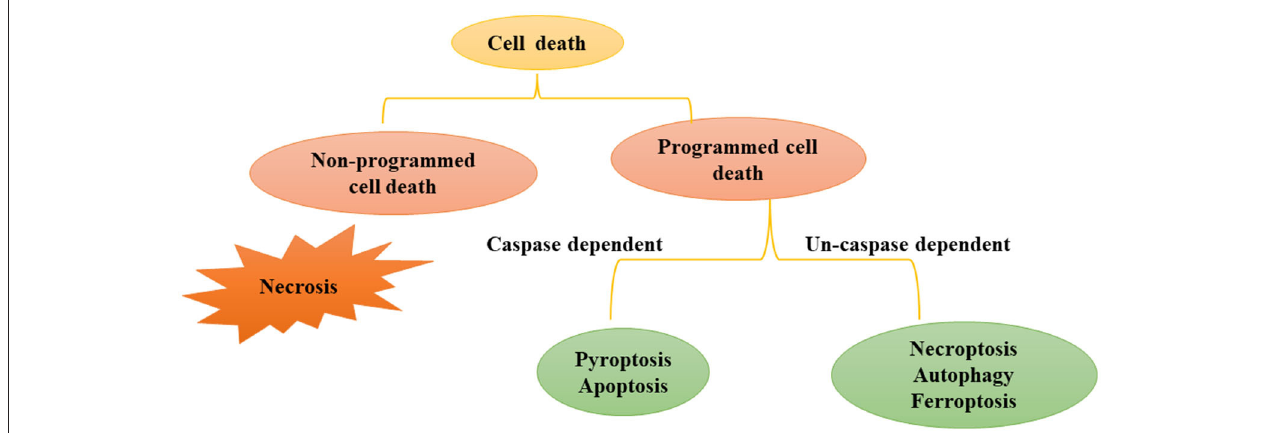
FIGURE 1 | Modes of Cell death: programmed cell death and non-programmed cell death. Cell death includes programmed cell death and non-programmed cell death. Non programmed cell death represents cell necrosis. Programmed cell death can be divided into caspase dependent cell death (such as apoptosis and pyroptosis) and non-caspase dependent cell death (For instance necroptosis, ferrotosis, autophagy, etc.).